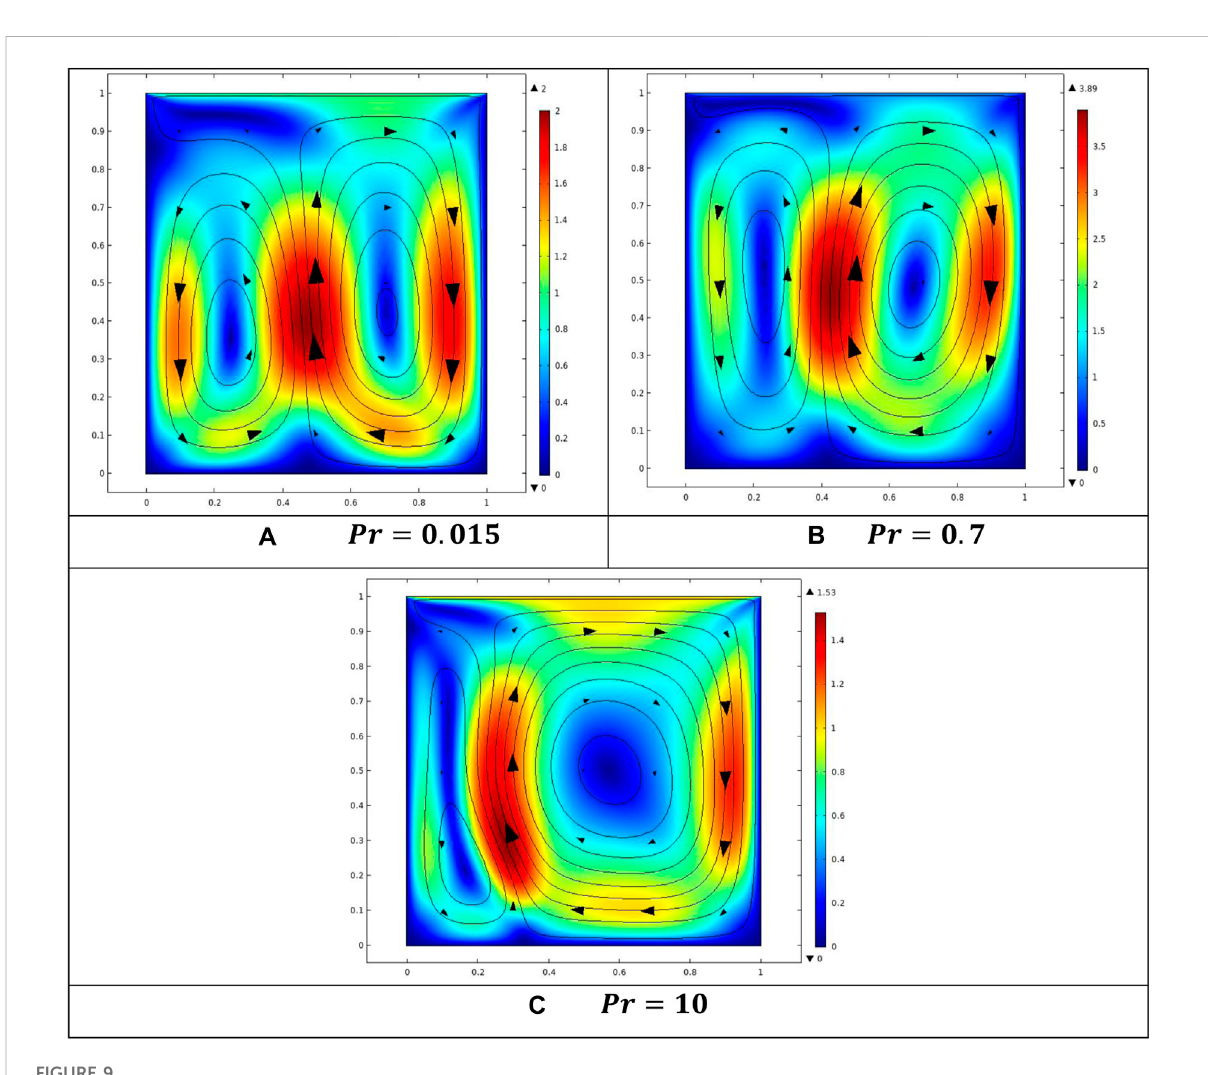
FIGURE 9 In fl uence of Pr on streamlines for the uniform heating case: (A) Pr (cid:1) 0 . 015, (B) Pr (cid:1) 0 . 7, and (C) Pr (cid:1)